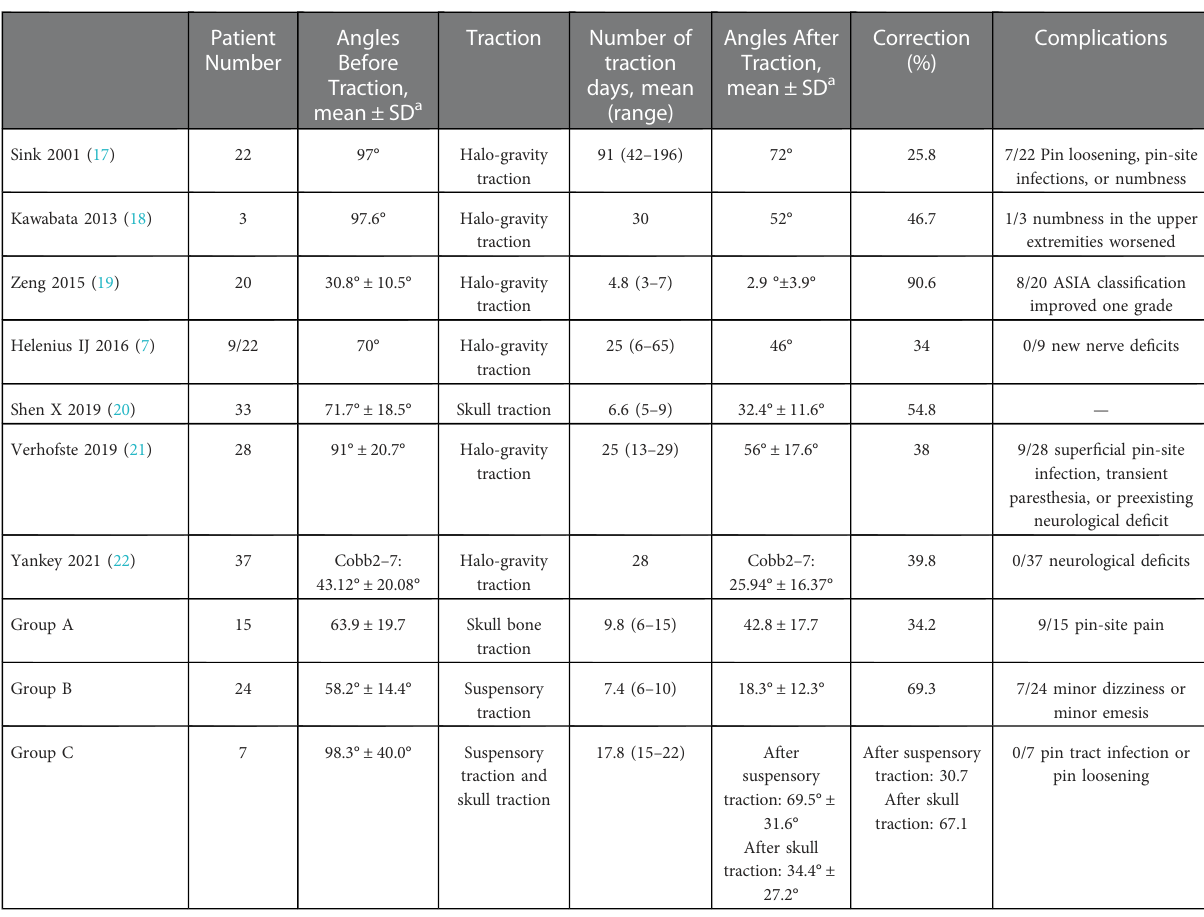
TABLE 5 Clinical results of pre-operative traction in different